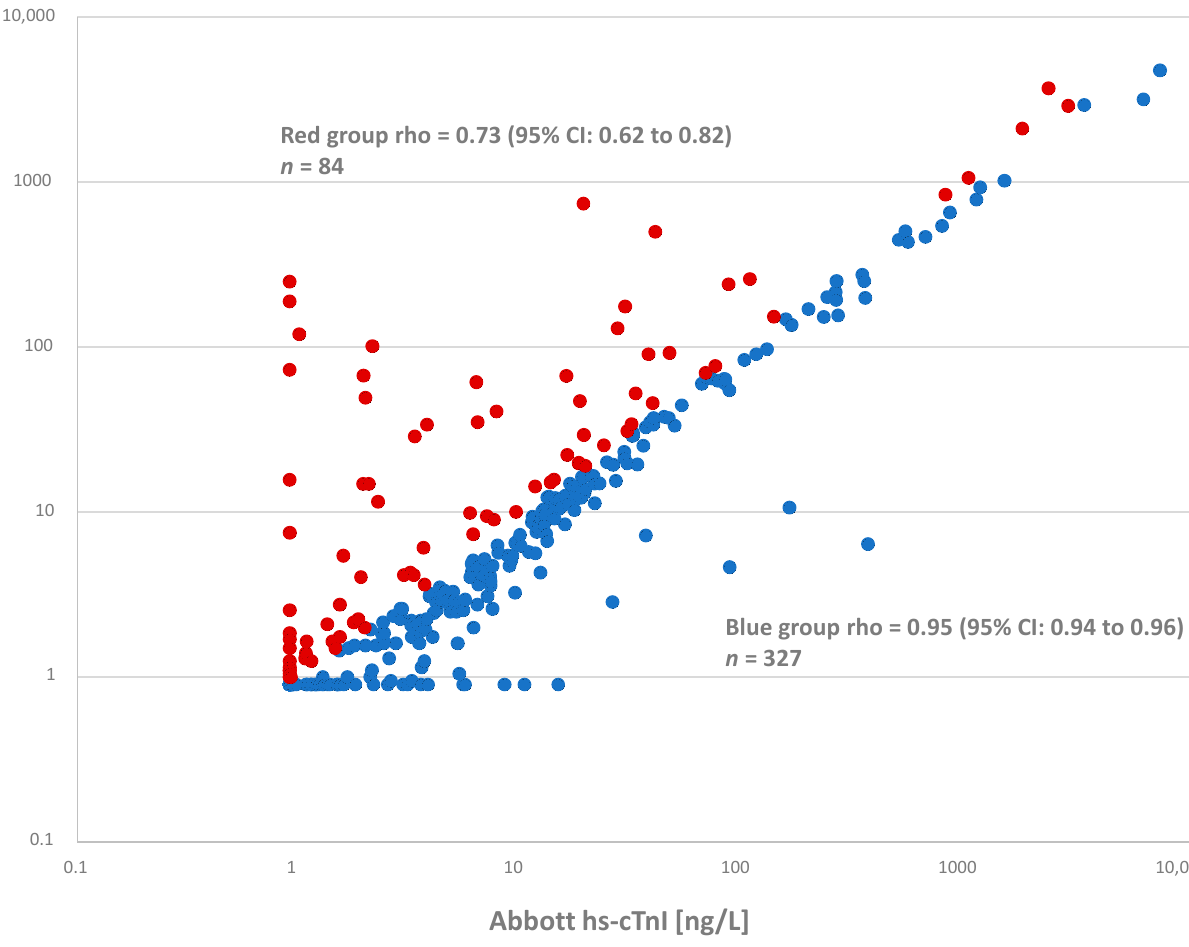
Figure 2. Correlation between the OCD hs-cTnI versus Abbott hs-cTnI assay using the average concentrations from the 411 lithium heparin plasma samples (Spearman rho = 0.87; 95% CI: 0.84 to 0.91). The red full circles ( n = 84) are paired results where OCD hs-cTnI is higher than Abbott hs-cTnI (Spearman rho = 0.73; 95% CI: 0.62 to 0.82) with the blue full circles ( n = 327) being paired results where OCD hs-cTnI is not higher than Abbott hs-cTnI (Spearman rho = 0.95; 95% CI: 0.94 to 0.96).